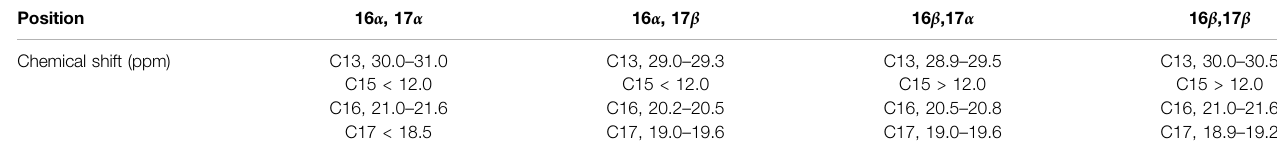
TABLE 2 | Previously reported rule for the identi fi cation of relative con fi gurations in side chain compounds (Bifulco et al., 2007). Position 16 α , 17 α 16 α , 17 β 16 β ,17 α Chemical shift (ppm)